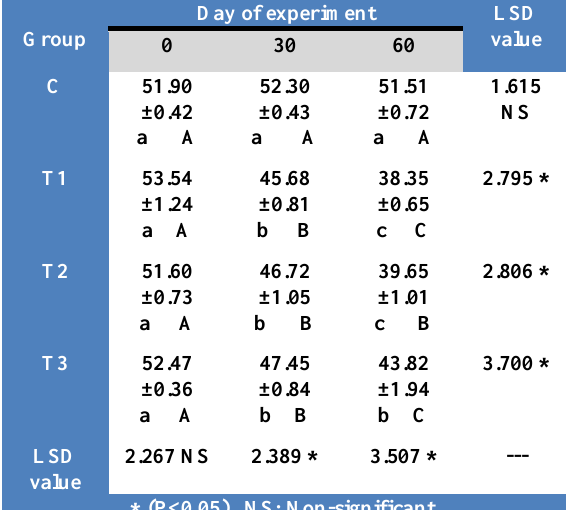
Table, 2: The effect of oral intubation for two months with sodium molybdate, sodium sulfate and their combination on serum Glutathione (GSH) (mg/dL) concentration of adult male